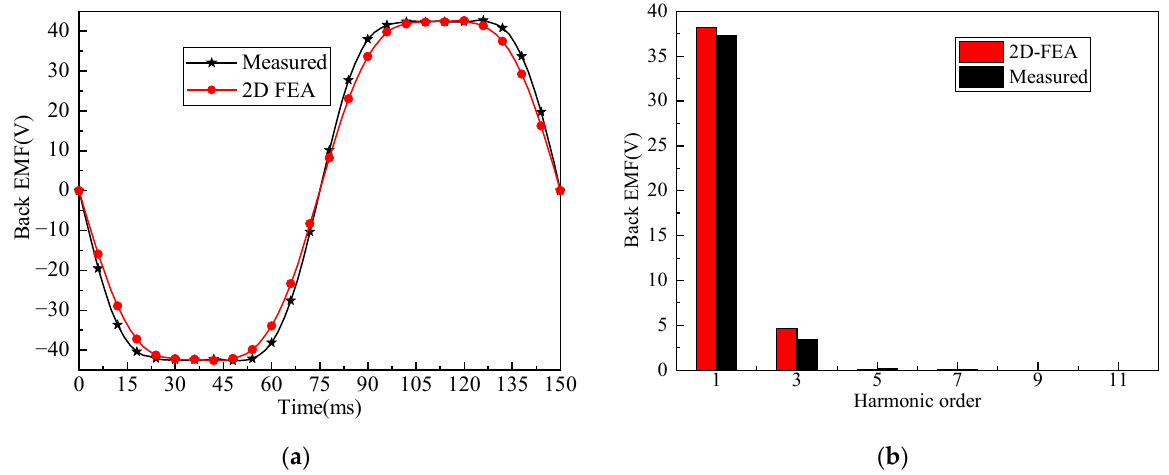
Figure 15. Two-dimensional FEM calculated and measured back EMF waveforms at 50 rpm: ( a ) waveforms; ( b ) harmonic analysis.